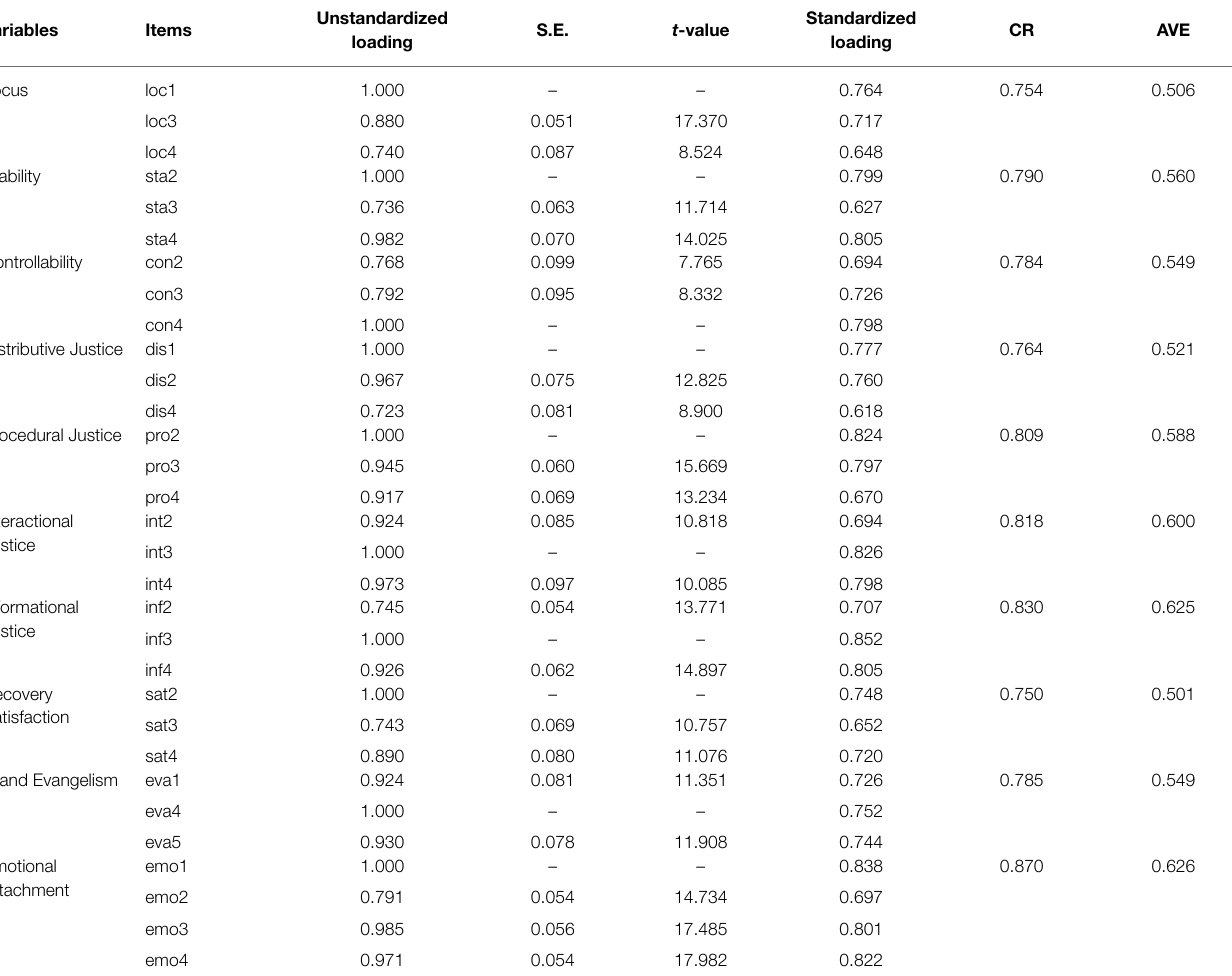
TABLE 2 | Results of confirmatory factor